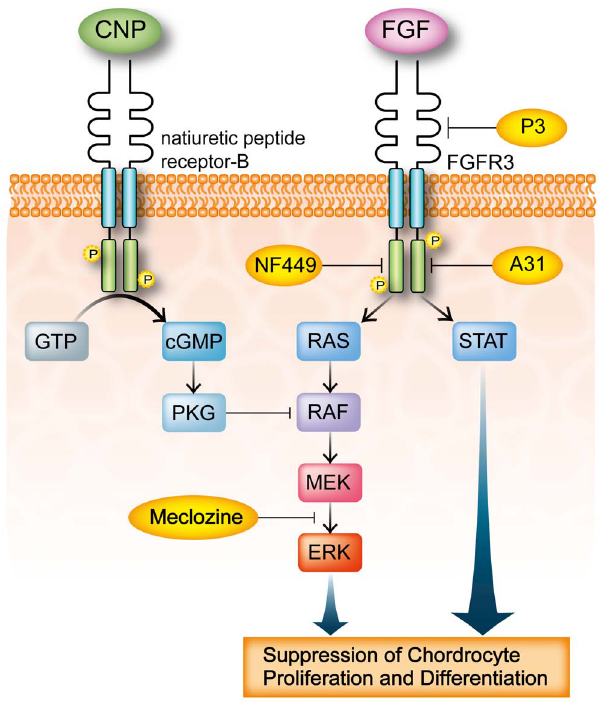
Figure 6. FGFR3 signal transduction in chondrocytes and mechanisms of FGFR3 inhibitors. Activations of MAPK (mitogen- activated protein kinase) and STAT (signal transducers and activators of transcription) negatively regulate chondrocyte proliferation and differ- entiation. MAPK signaling includes sequential stimulation of a signaling cascade involving RAS, RAF, MEK, and ERK. CNP binding to natriuretic peptide receptor-B induces the generation of the second messenger cGMP, which activates PKG and leads to attenuation of the MAPK pathway by inhibiting RAF activation. NF449 [14], A31 [16], and P3 [15] are recently identified FGFR3 inhibitors. NF449 and A31 have inhibitory effects on the kinase activity of FGFR3. P3 has an affinity for extracellular domain of FGFR3. Meclozine attenuates ERK